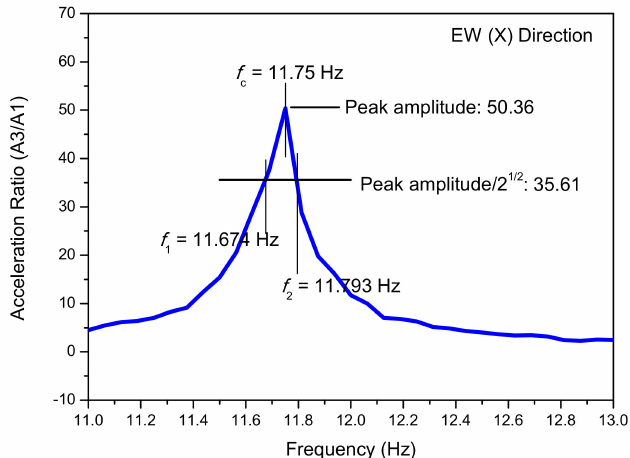
Figure 14. Spectrum illustrating the half-power bandwidth method for damping estimation (1st EW mode).